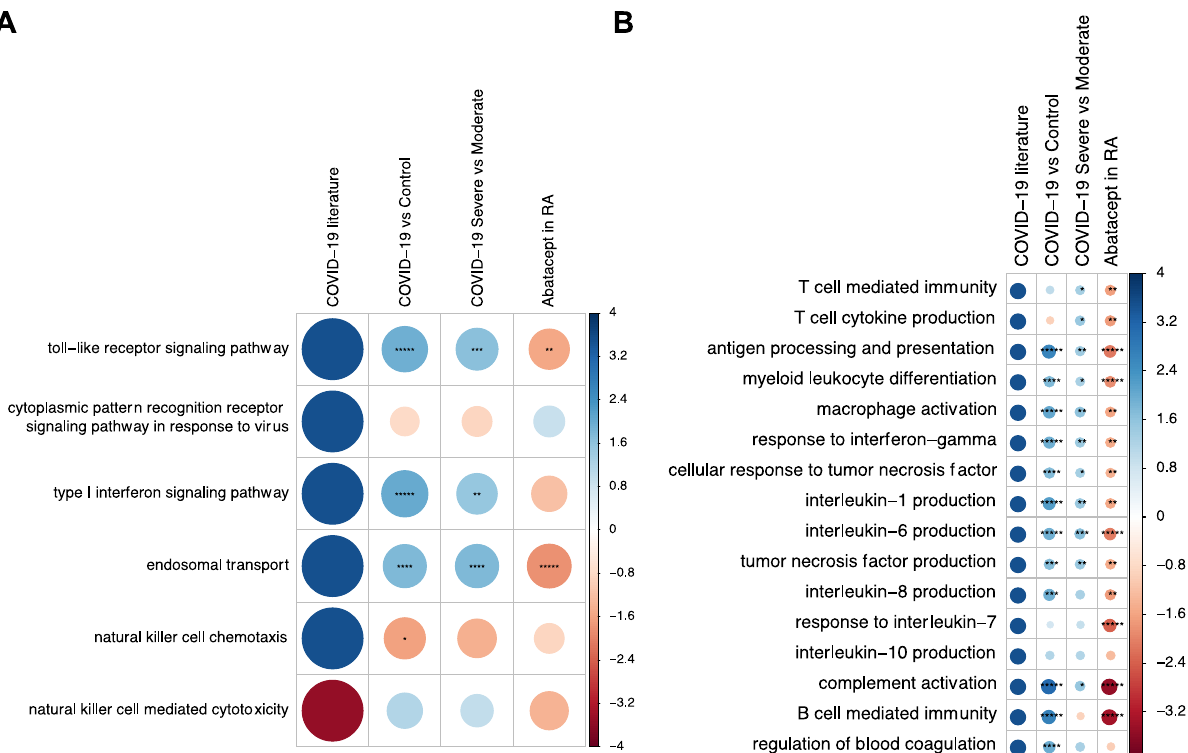
Figure 1. Changes induced by abatacept in key COVID-19 pathological processes. ( A ) Biological processes associated with immune viral response (first step of COVID-19 response). ( B ) Biological processes associated with hyperinflammation and severity (second step in COVID-19). The first column indicates the direction of change of the biological process induced by COVID19 as described in different clinical studies (solid blue: up-regulation, solid red: down-regulation, as measured by the GSEA Normalized Enrichment Score -NES-). The last column shows the direction (blue: upregulation, red: downregulation) and statistical significance of the change induced in the COVID-19 associated processes at the systemic level by the treatment with abatacept. Circle size is also proportional to the NES. P-value significance levels are indicated as *< 0.05, **< 0.005, ***< 0.0005, ****< 0.00005 and *****< 0.000005. The two middle columns show the change and statistical significance of these processes in the early COVID-19 cohort (comparing COVID-19 patients to healthy controls), and the late COVID-19 cohort (comparing severe to mild